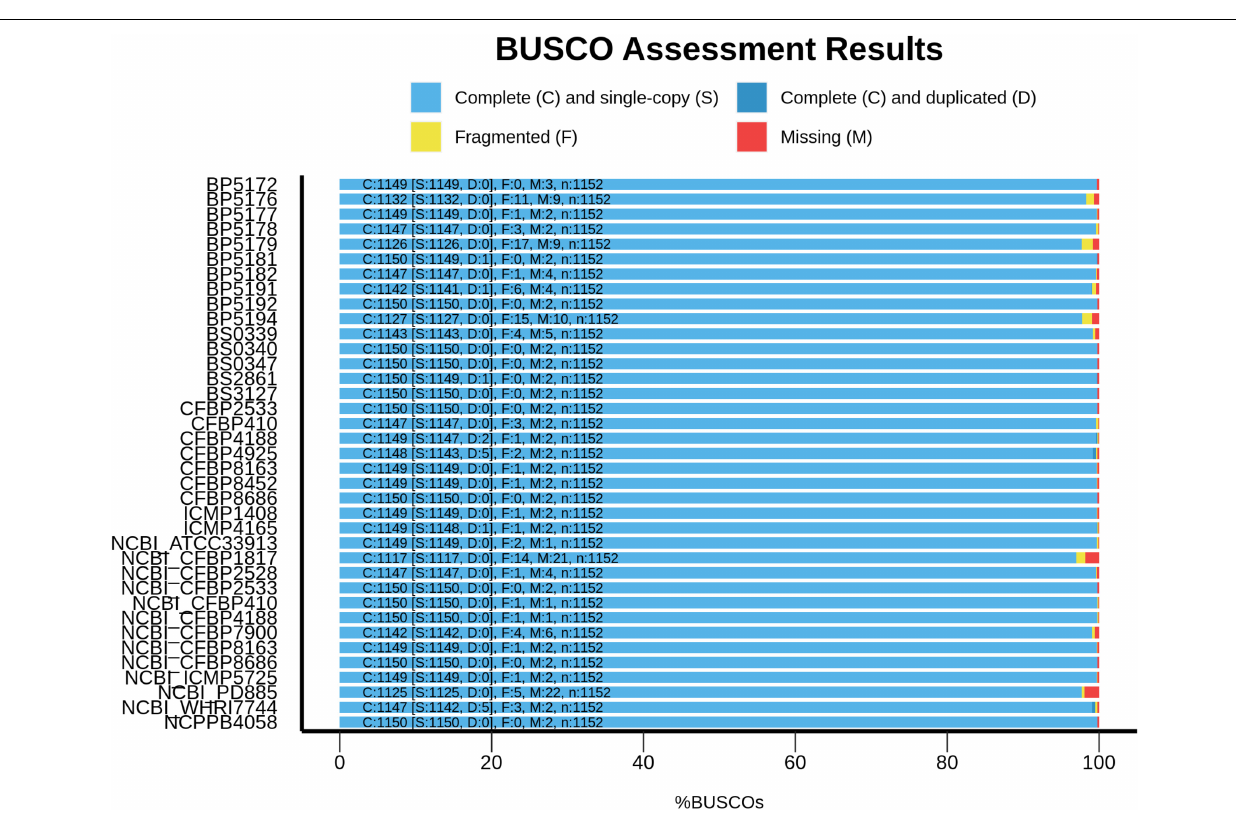
FIGURE 2 | Genome assembly completeness assessment for Xhv and related strains. The completeness of the genome assemblies produced in this study was evaluated using the benchmarking universal single copy orthologs method (BUSCO; Manni et al., 2021). The proportions of complete and single-copy orthologs in these assemblies were compared to those of previously published Xanthomonas assemblies retrieved from NCBI’s genome database, including X. campestris pv. campestris (ATCC 33913 T ; GenBank assembly accession GCA_000007145.1), X. populi (CFBP 1817 T ; GCA_002940065.1), X. arboricola pv. juglandis (CFBP 2528 T ; GCA_001013475.1), X. hortorum pv. pelargonii (CFBP 2533 PT ; GCA_012922215.1), X. hortorum pv. taraxaci (CFBP 410 PT ; GCA_012922225.1), X. hortorum pv. cynarae (CFBP 4188 PT ; GCA_002939985.1), X. hortorum pv. carotae (CFBP 7900; GCA_000505565.1), X. hortorum pv. gardneri (CFBP 8163 PT